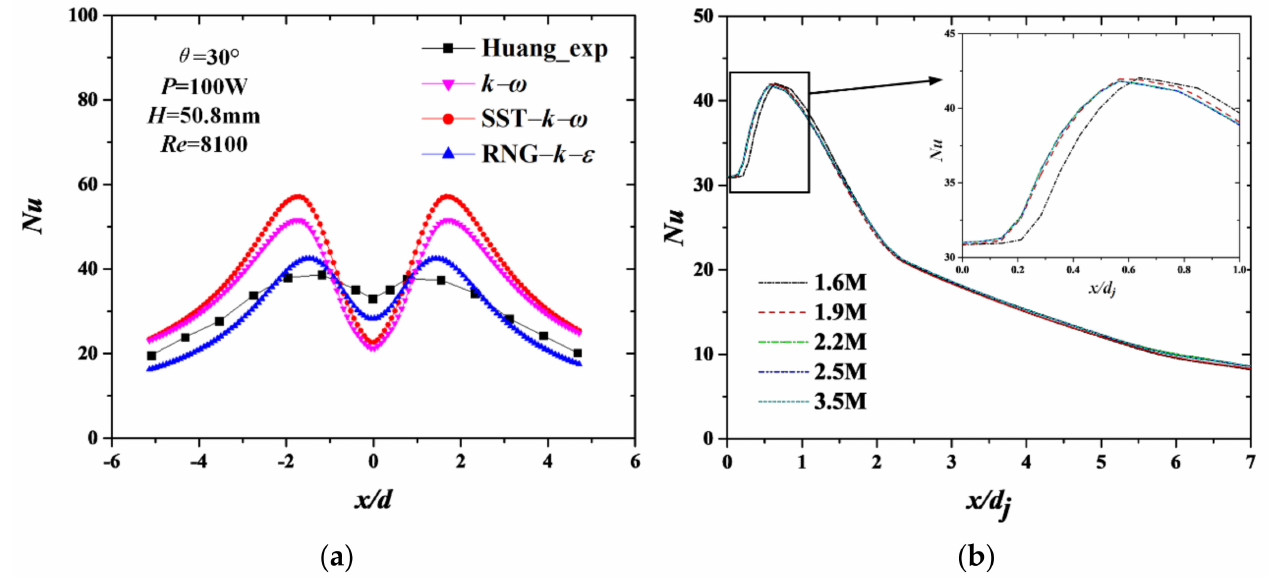
Figure 3. Verification of the numerical method: ( a ) turbulence model and ( b ) grid independence.